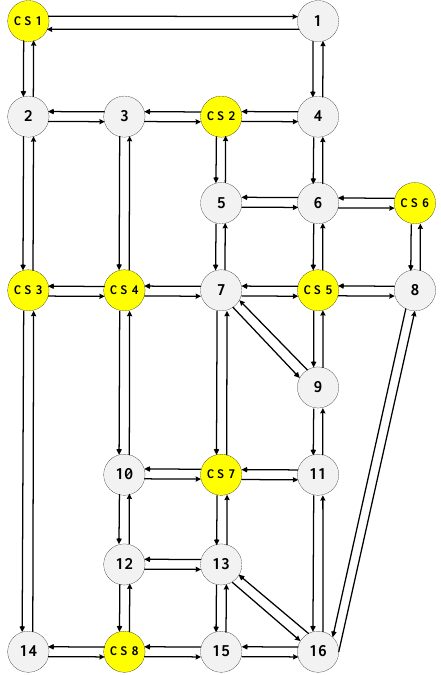
Figure 5. Sioux Falls road network for the simulation example.